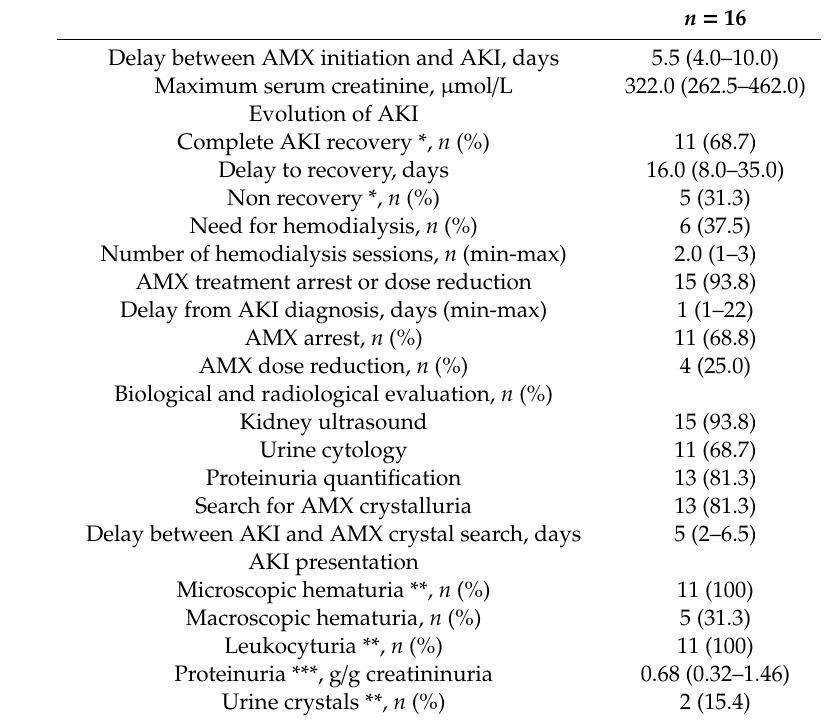
Table 4. Description of AMX-induced crystal nephropathy (AICN) cases. Results are presented as median (IQR) and absolute value (percentage).